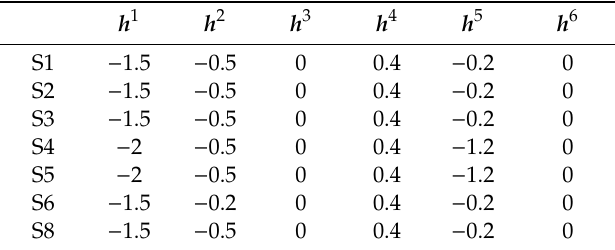
Table 3. h parameters